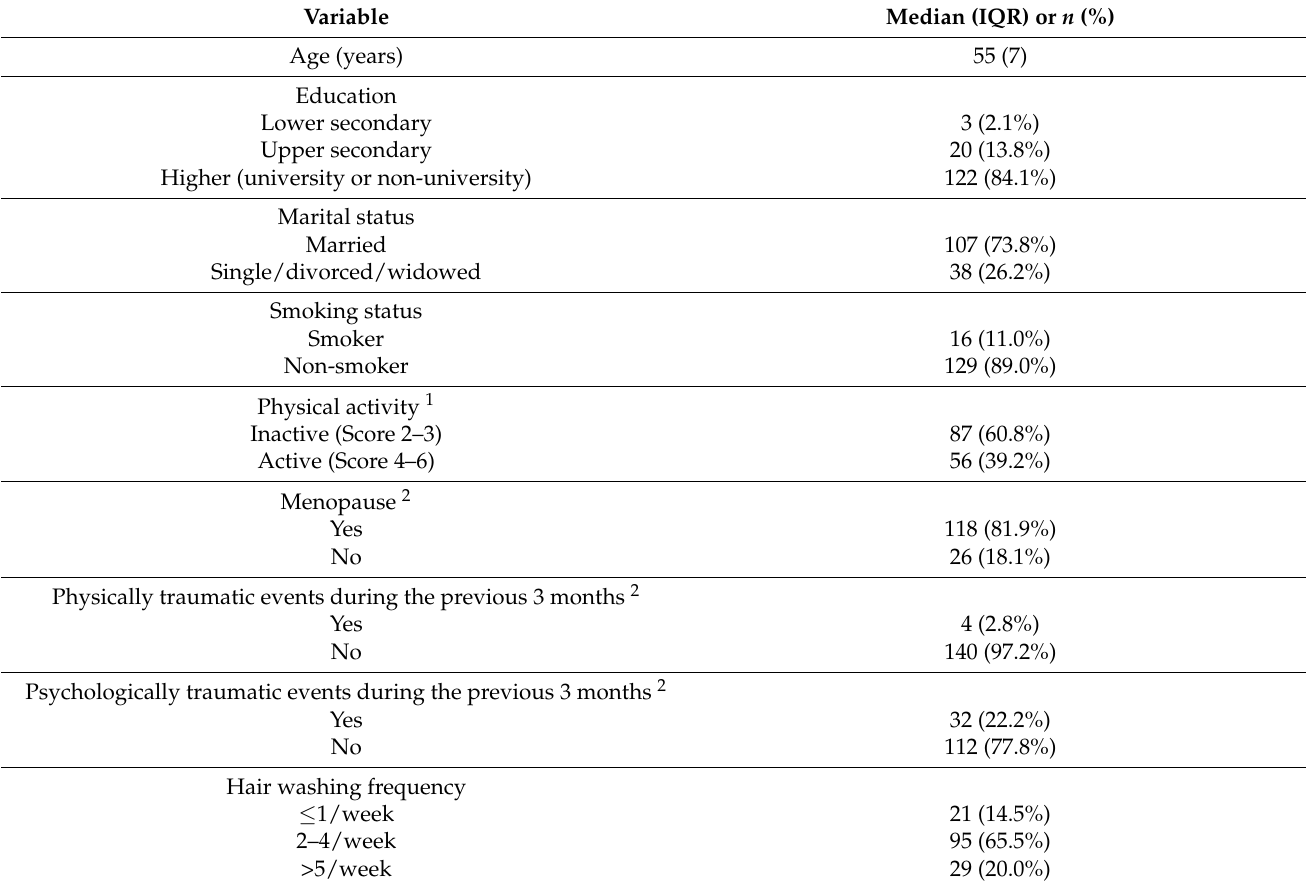
Table 1. Sociodemographic, lifestyle and health-related characteristics of the study participants.